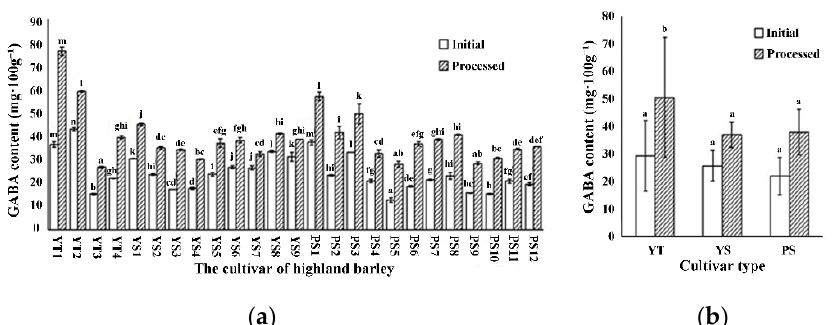
Figure 2. Effects of cultivars on GABA content. ( a ) The cultivar variation in GABA content; ( b ) the difference of GABA content among different cultivar types. Initial, the initial GABA content of high- land barley; Processed, the GABA content of highland barley after HRH treatment. Different letters denote significant difference among different highland barley cultivars ( a ) or cultivar types ( b ) at the level p < 0.05.